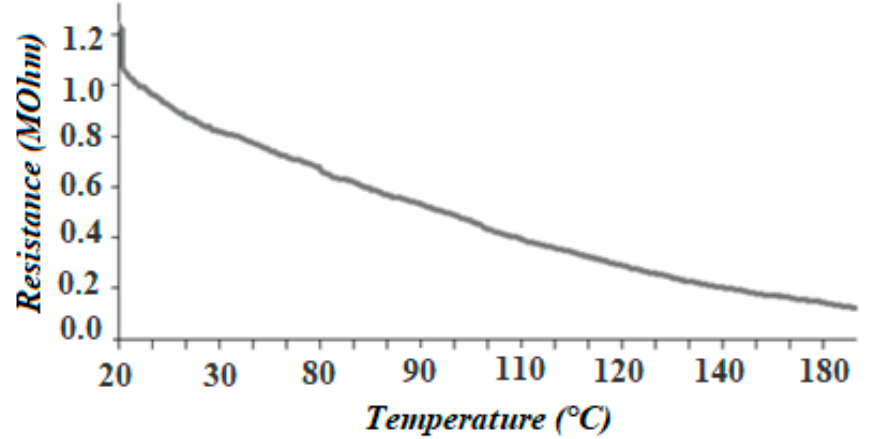
Figure 10. Dependence of the sensor resistance on operating temperature (for the sample thermally treated at 500 °C).